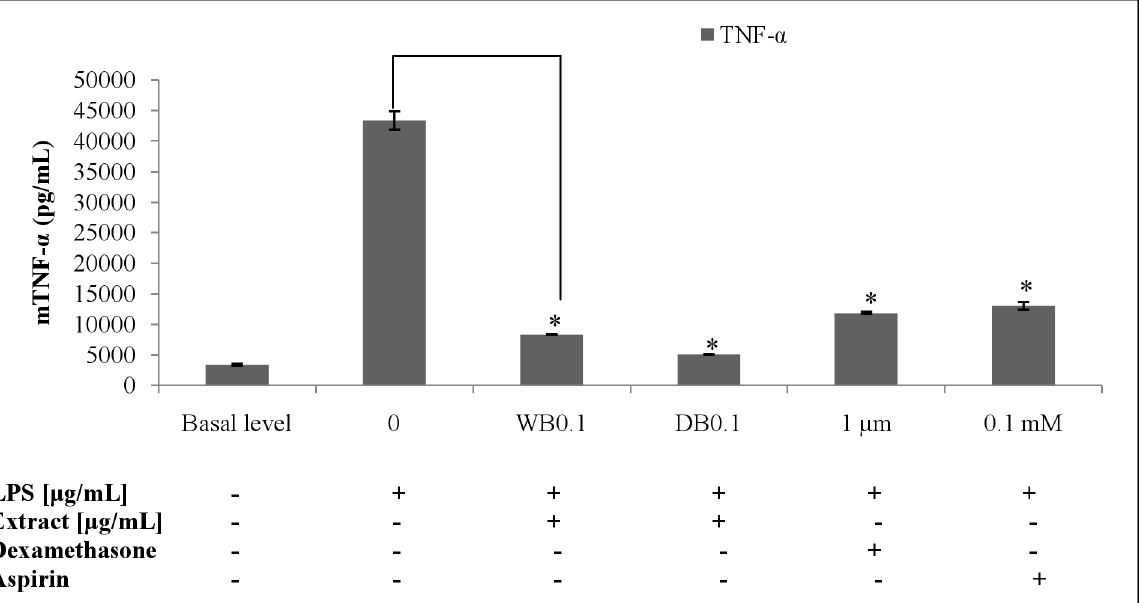
Fig 7. Effects of A . rugosum extracts on TNF- α cytokine level (S1 Dataset). RAW264.7 cells were co-incubated with A . rugosum extracts (WB0.1: 0.1 μ g/ mL WB; DB0.1: 0.1 μ g/mL DB) and 1 μ g/mL LPS for 24 hrs. Dexamethasone (1 μ M) and aspirin (0.1 mM) served as positive controls. Results shown represent the mean ± SD, n = 3 and * p < 0.05 versus LPS-induced NO level alone.